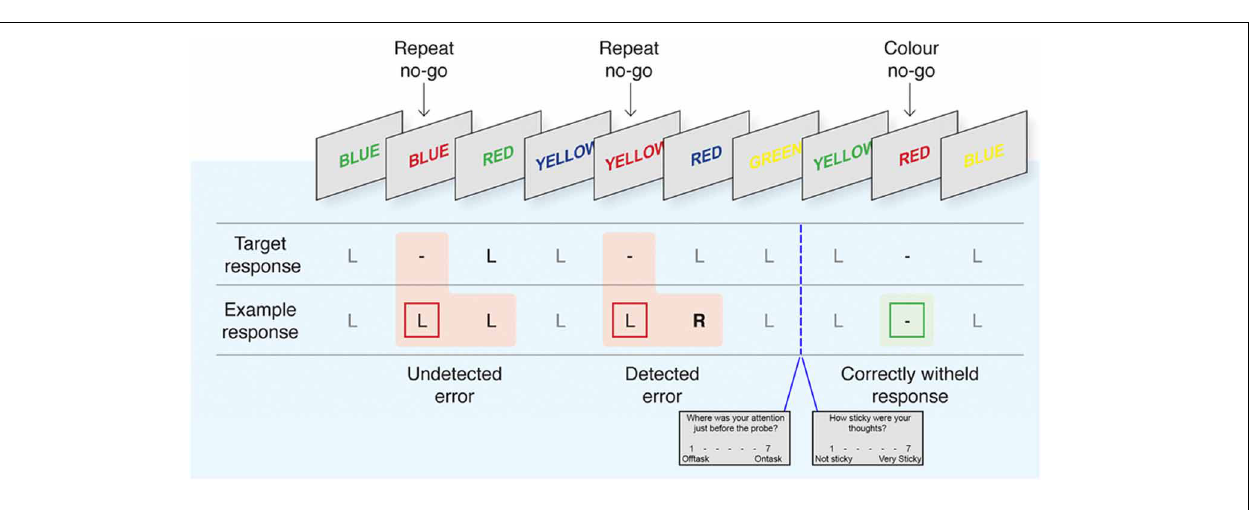
FIGURE 1 | The EAT task with interleaved thought probes. Adapted with permission from Hester et al. (2012). Participants respond by pressing the left button (L) during Go trials and withhold from responding ( − ) to repeated or font-color matching words. Following commission errors, participants are trained to forgo the normal